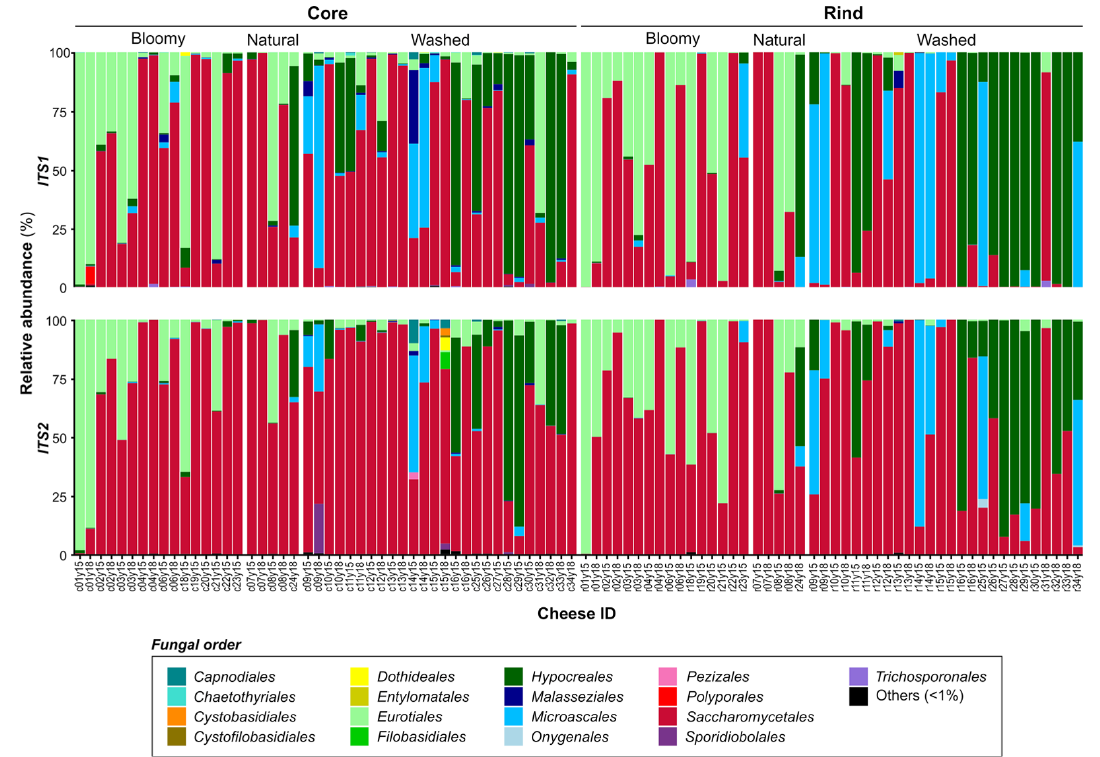
Figure 2. Comparative distribution of the most abundant fungi in cheese ecosystems. Each col- umn shows the relative abundance of the fungal (ITS) microbiota representing over 1% of the average abundance (order <1% are combined and shown in black). Vertical sections show different ITS targets: the top row shows ITS1 data, and the bottom row shows ITS2 data. Horizontal sections show different parts of the cheese according to the rind type (bloomy, natural or washed): the left row shows cheese core data, and the right row shows cheese rind data. The last number of the cheese ID refers to the year of production (2015 or 2018) for the 32 cheese